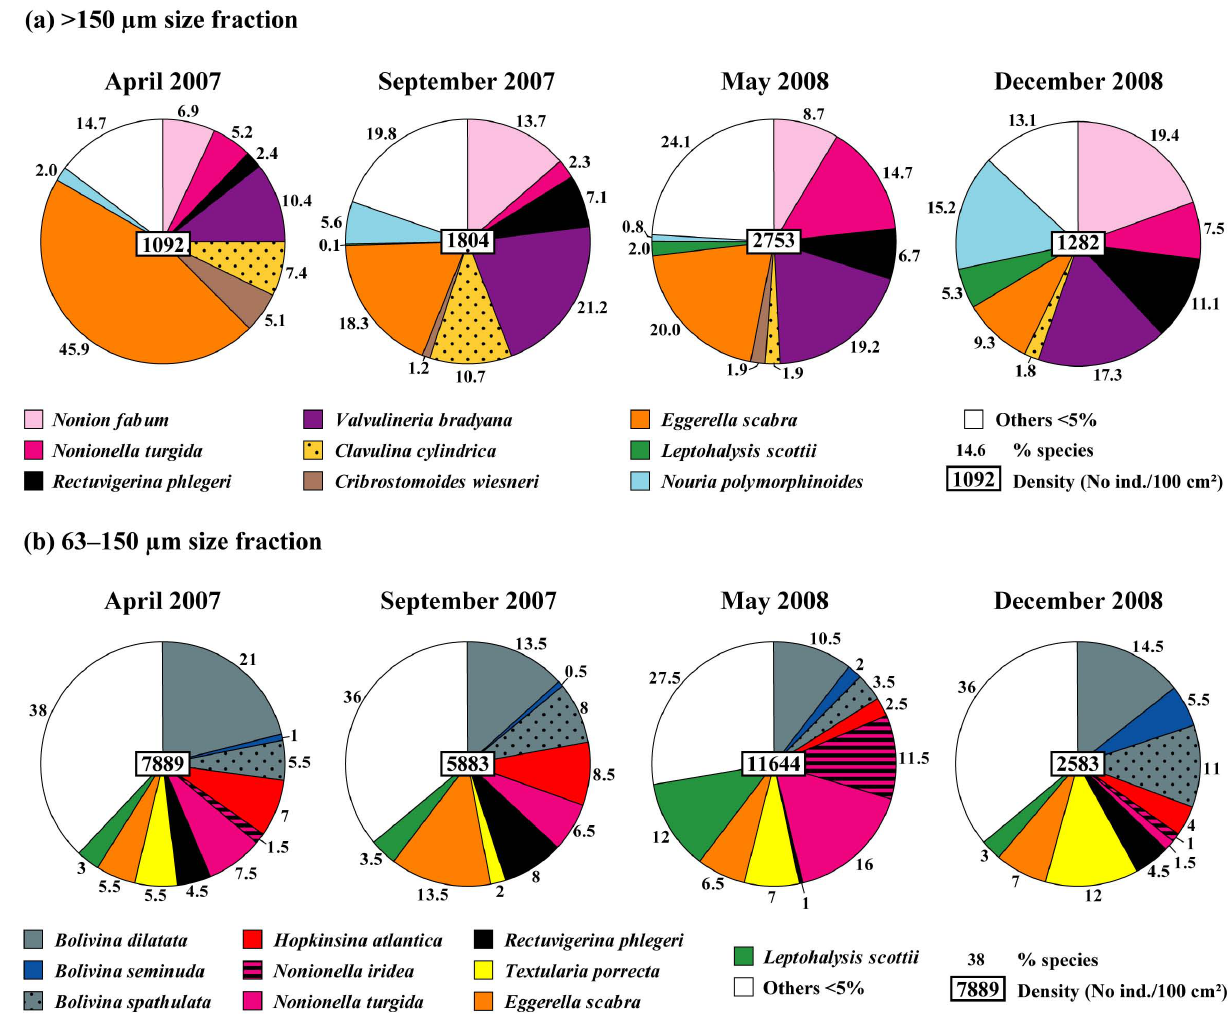
Fig. 8. Relative abundances of the major species in the > 150µm (a) and the 63–150µm size fractions (b) at Station N for the four sampling